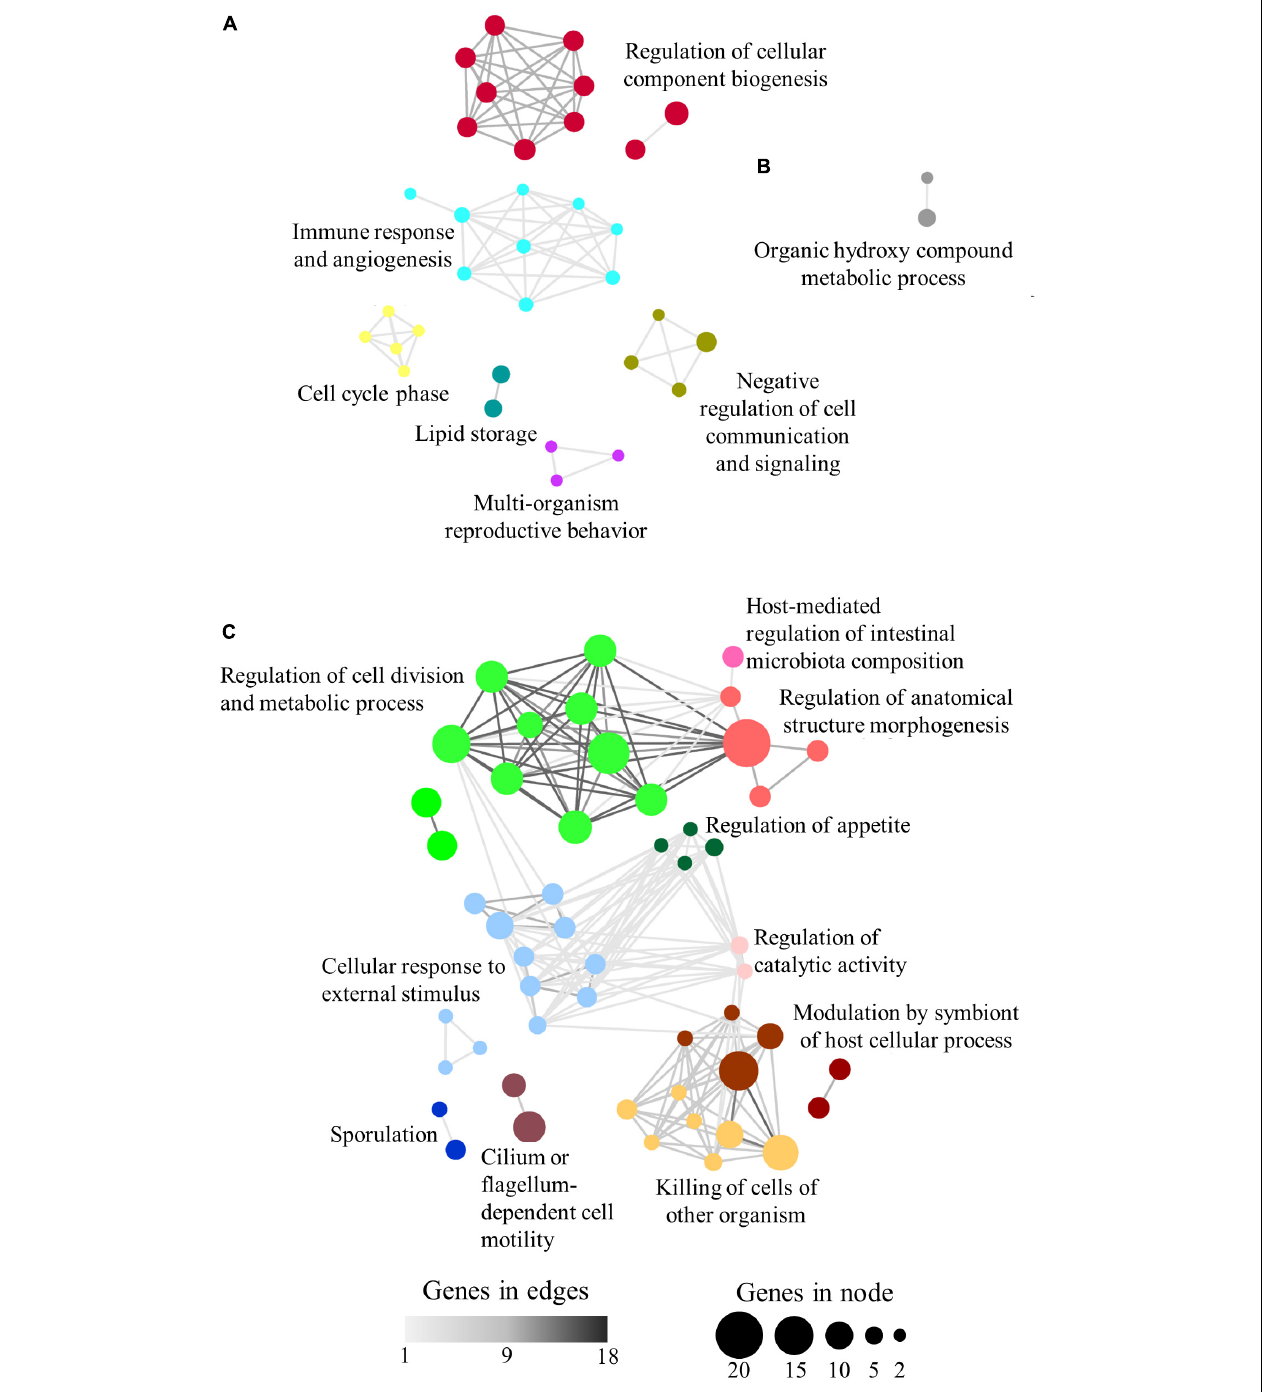
FIGURE 4 | Network layout representing the associations between over-represented GO-BP terms according to their shared allocated genes in panels (A) C1 + C3, (B) C2, and (C) C4. Node size represents the number of genes allocated to a specific GO-BP term. Node colours show the representative name of clustered GO-BP terms. Edge width represents the number of shared genes between two GO-BP